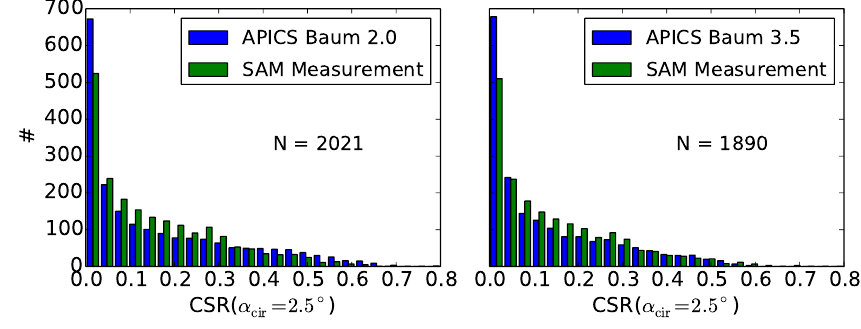
Fig. 12. Histograms of the circumsolar ratio (CSR) time series measured by SAM and retrieved from SEVIRI that were used for the validation Fig.12. Histogramsofthecircumsolarratio(CSR)timeseriesmeasuredbySAMandretrievedfromSEVIRIthatwereusedforthevalidation